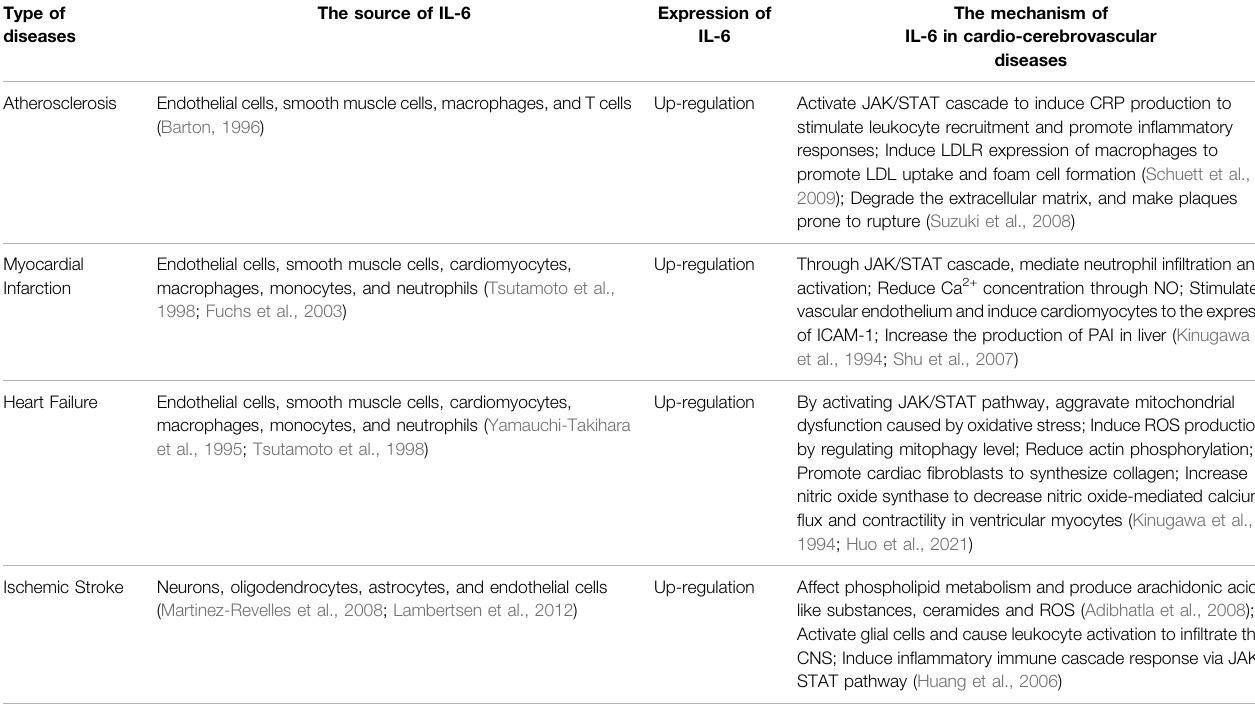
TABLE 2 | Role of Interleukin-6 in cardio-cerebrovascular diseases.